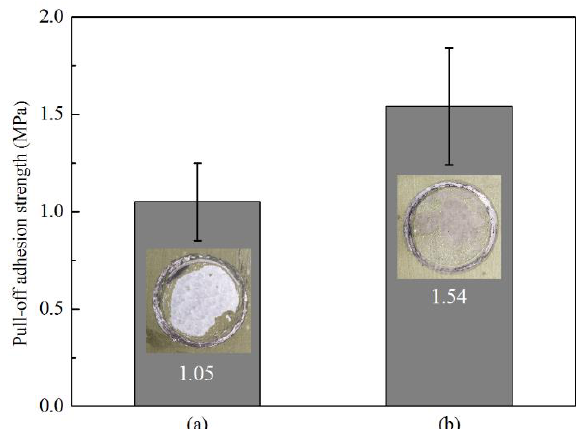
Figure 7. Pull-off adhesion strength measurements of the epoxy coatings applied on ( a ) degreased Zn55Al specimens; ( b ) Zn55Al specimens treated by 180 s at 40 ◦ C.